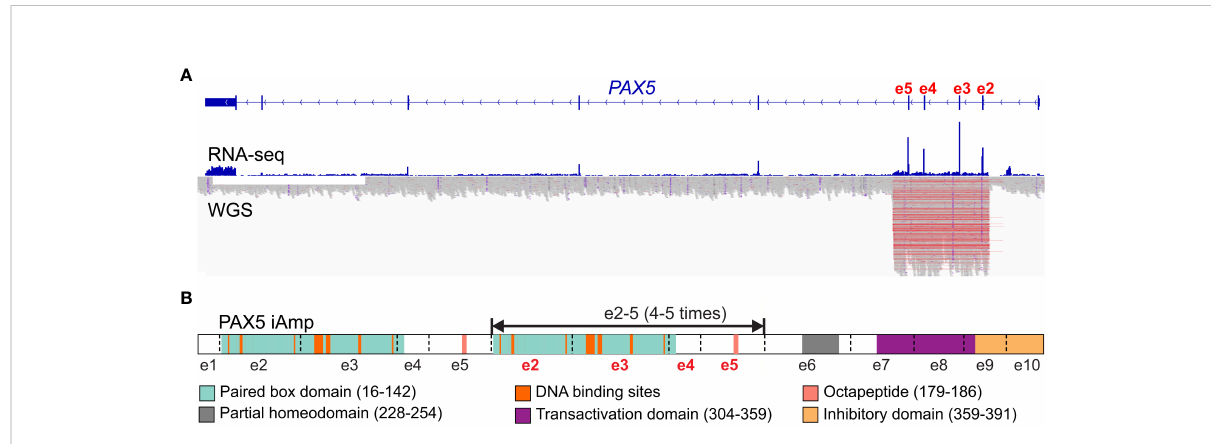
FIGURE 3 Scheme of PAX5 intragenic ampli fi cation ( PAX5 iAmp). (A) PAX5 iAmp detected by RNA-seq and whole genome sequencing (WGS (16)). The most frequently affected exons are e2-5, which are shown with increased expression levels (by RNA-seq) compared to the adjacent exons. The ampli fi ed region on the genomic level is re fl ected by abruptly elevated depth from WGS, which corroborates the affected exons identi fi ed from RNA-seq. (B) PAX5 iAmp leads to an extended isoform of PAX5 . Using optical genomic mapping, 4-5 extra copies of PAX5 e2-5 were determined in the PAX5 iAmp cases. The tandem multiplication of PAX5 paired box DNA binding domain may change its binding activity, thus altering its transcription program and disrupting B cell differentiation